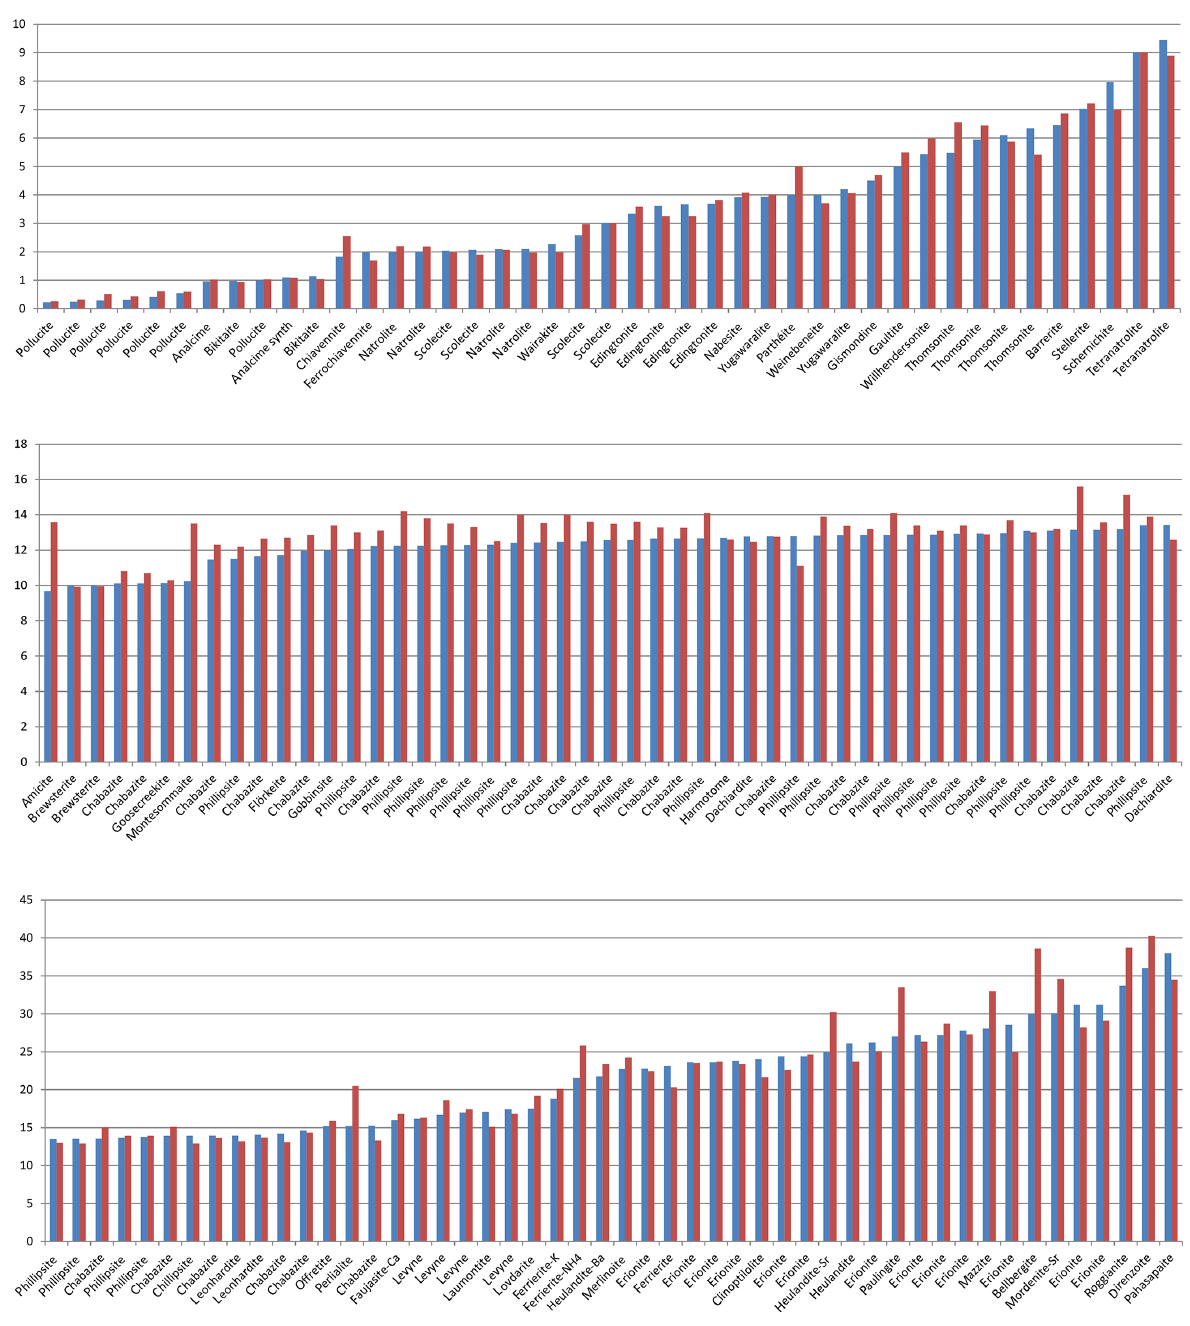
Figure 1. Histogram of observed (blue) and calculated (red) water content. Entries 145 to 149 are omitted (see text for explanation). The two entries with H 2 O content > 50 (8 – boggsite; 69 – gottardiite) are not